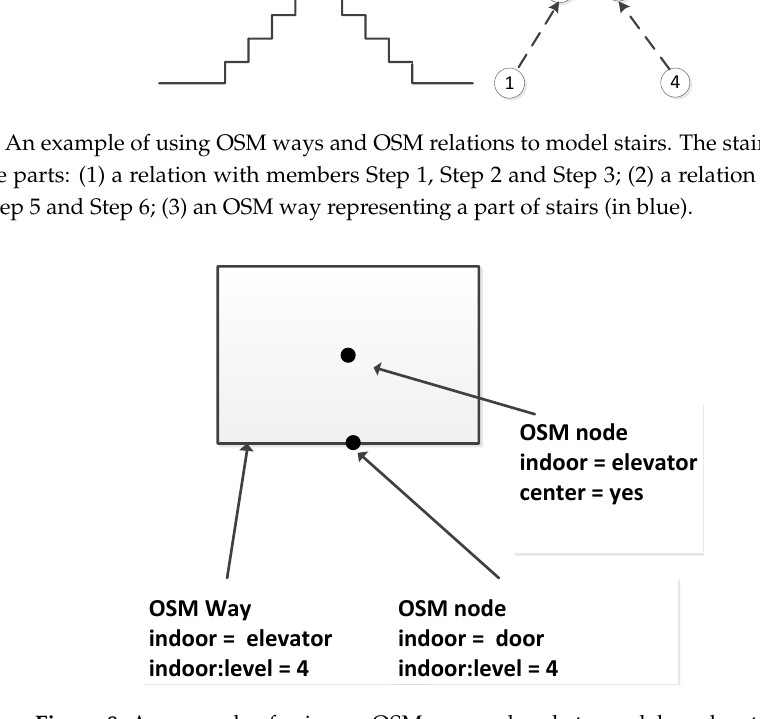
Figure 8. An example of using an OSM way and node to model an elevator.